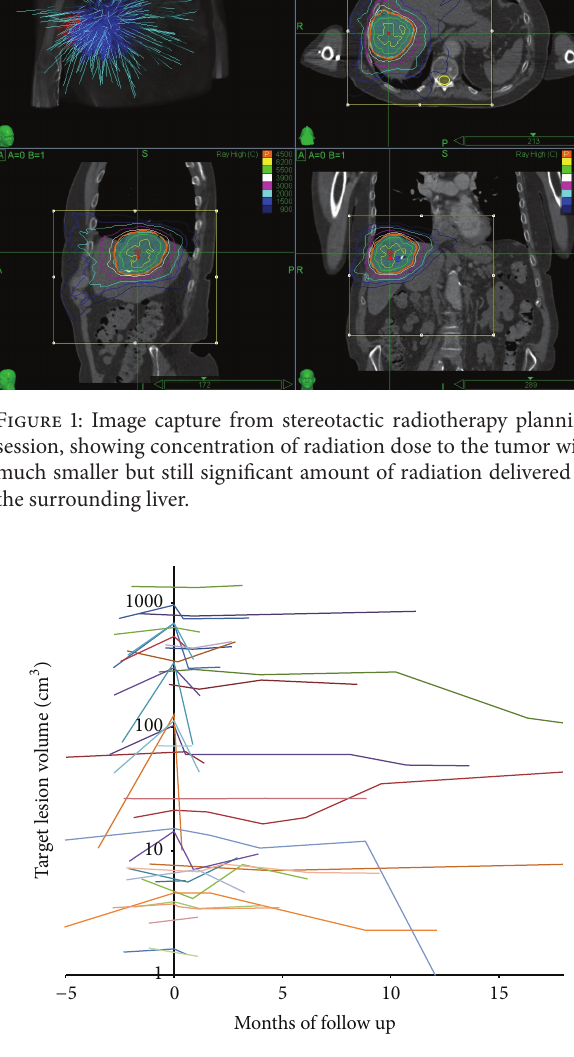
Figure 2: Target lesion volume changes in hepatocellular carci- noma patients (each curve denotes an individual lesion). Most of the lesions show volume decrease most prominently soon after treatment, with some lesions demonstrating further slower volume decrease with time. In a few cases there was an increase in volume later on, corresponding to recurrence.